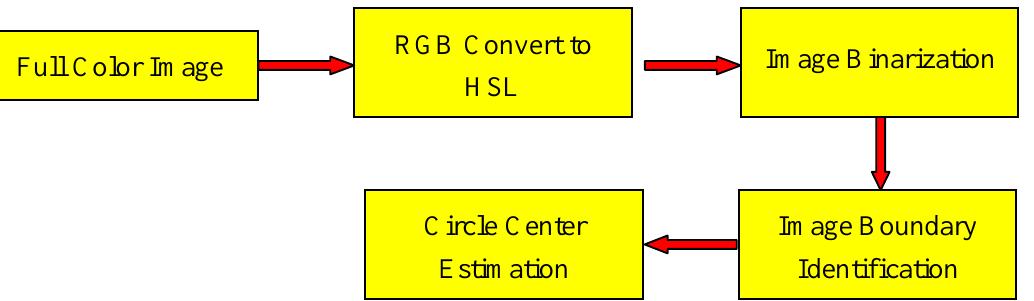
Figure 4. Procedure of estimating the Sun image center with image